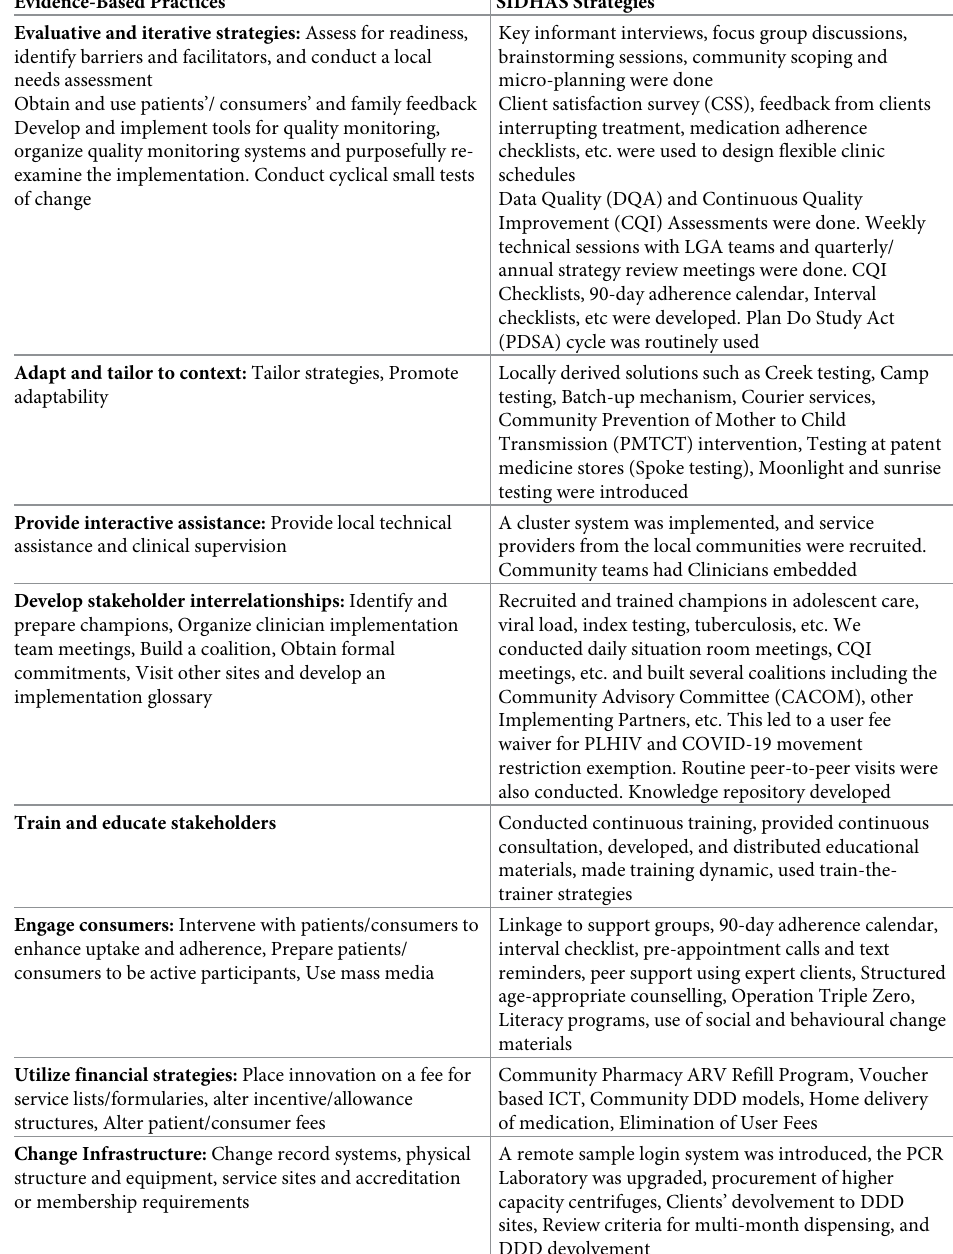
Table 1. Evidence-based practices implemented as SIDHAS Strategies during the surge in Akwa Ibom, Nigeria (April 2019–March 2021). Evidence-Based